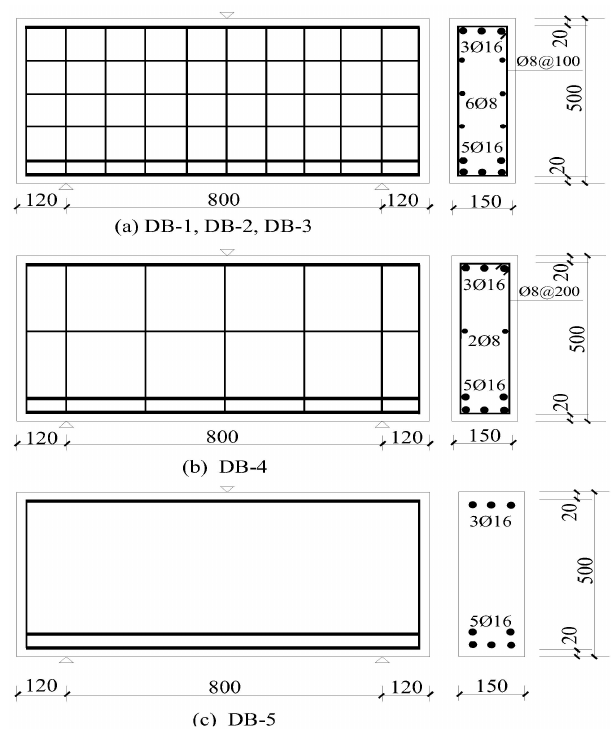
Figure 6. Reinforcement configuration of specimens. ( a ) DB-1, DB-2, DB-3; ( b ) DB-4; ( c ) DB-5.